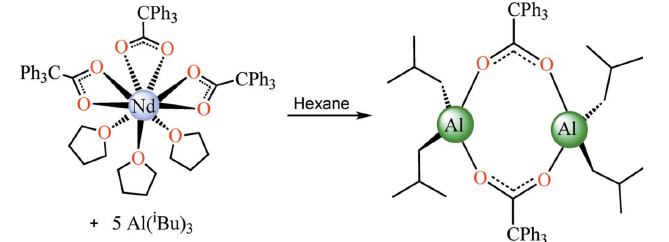
Figure 1 Synthesis of [Al(iBu) 2 ( (cid:2) -O 2 CCPh 3 )] 2